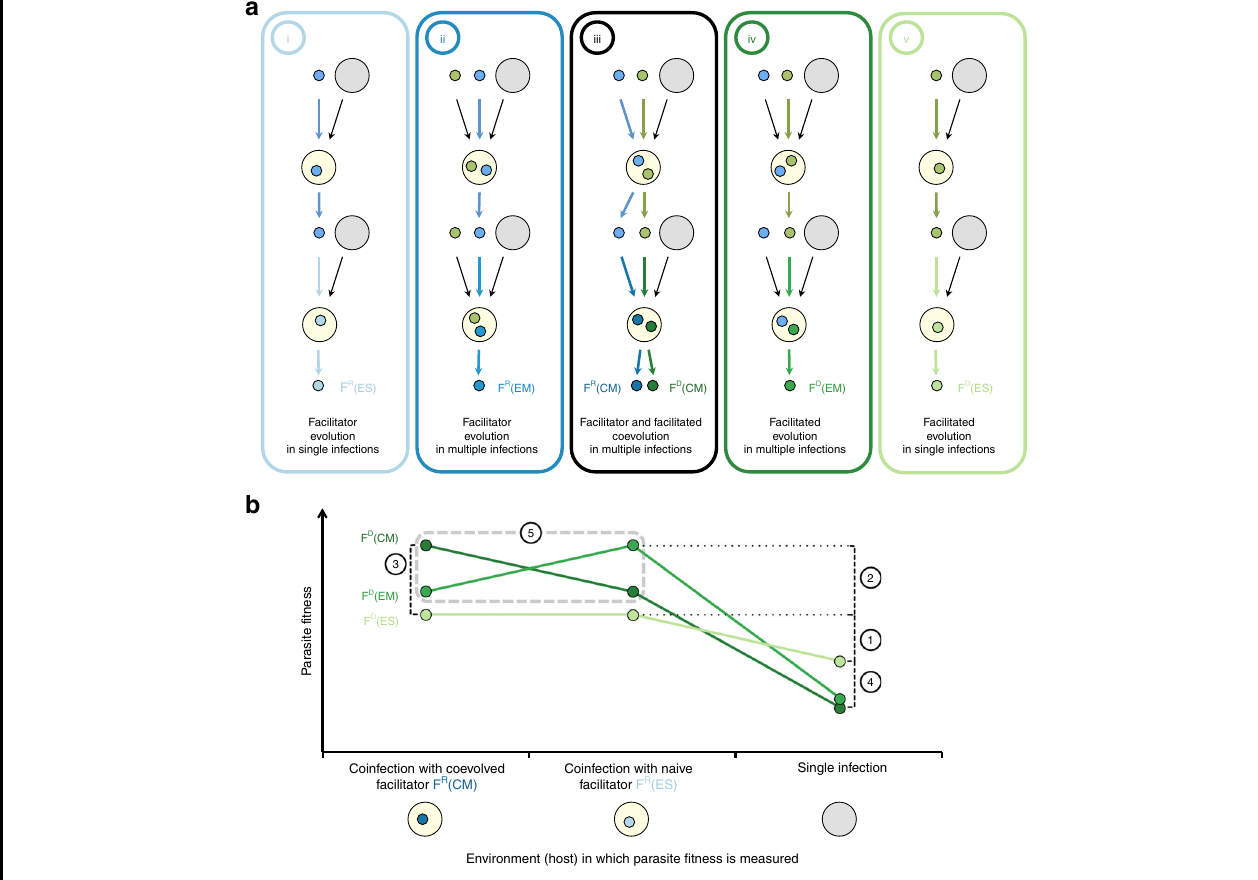
Fig. 4 Proposed experimental design to test the evolution of facilitation. a Experimental design required to measure evolved responses to facilitation. Small green circles: facilitated symbionts (F D ); small blue circles: facilitator symbionts (F R ); big grey circles: hosts. Bold coloured arrows: (co)evolving players; thin black arrows: naive players (i.e. introduced from a naive base population at each generation). Treatments: (i) evolution of the facilitator in single infections: F R (ES); (ii) evolution of the facilitator in multiple infections: F R (EM); (iii) coevolution of the facilitated and facilitator in multiple infection: F R (CM) and F D (CM), respectively; (iv) evolution of the facilitated in multiple infections: F D (EM); (v) evolution of the facilitated in single infections: F D (ES). b Example of a possible evolved response of local adaptation in which facilitated symbionts have higher fi tness when assayed in the infection environment in which they evolved. (1) Facilitation; (2) adaptation to the presence of a facilitator; (3) adaptation to the presence of a coevolved facilitator; (4) cost of adaptation to the facilitator; (5) local adaptation to either a coevolved or evolved